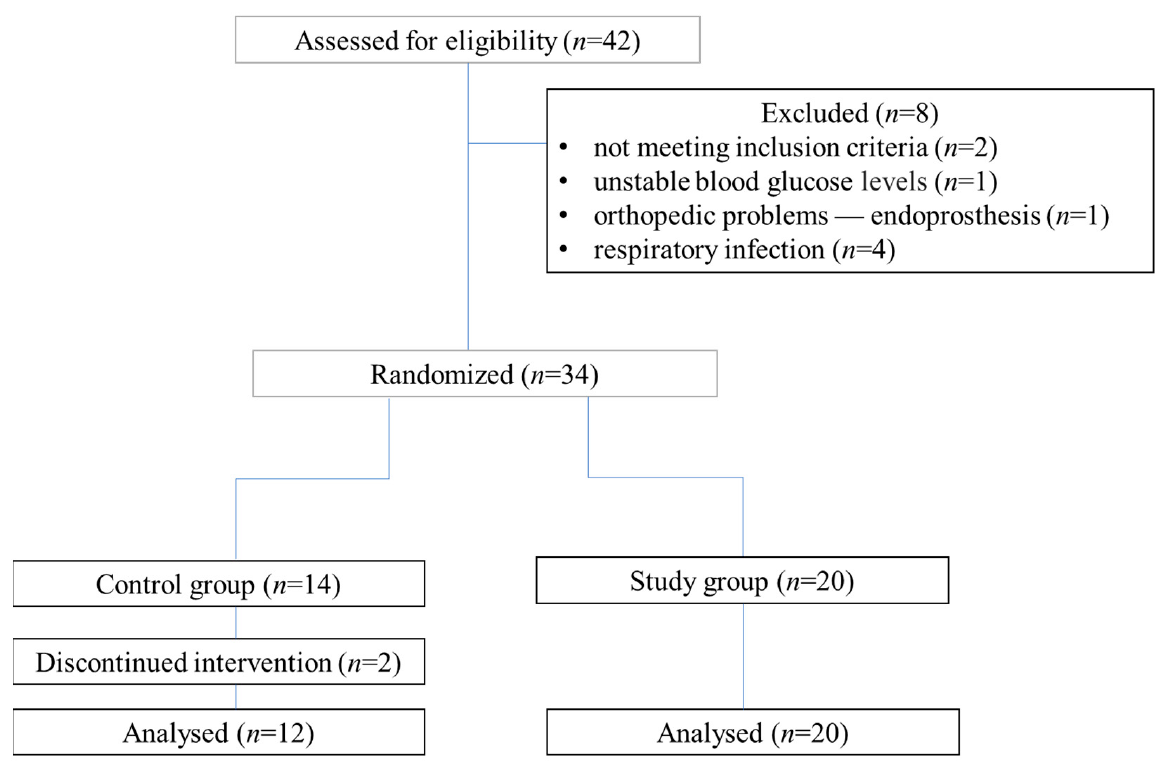
Figure 1. Patient flow chart.